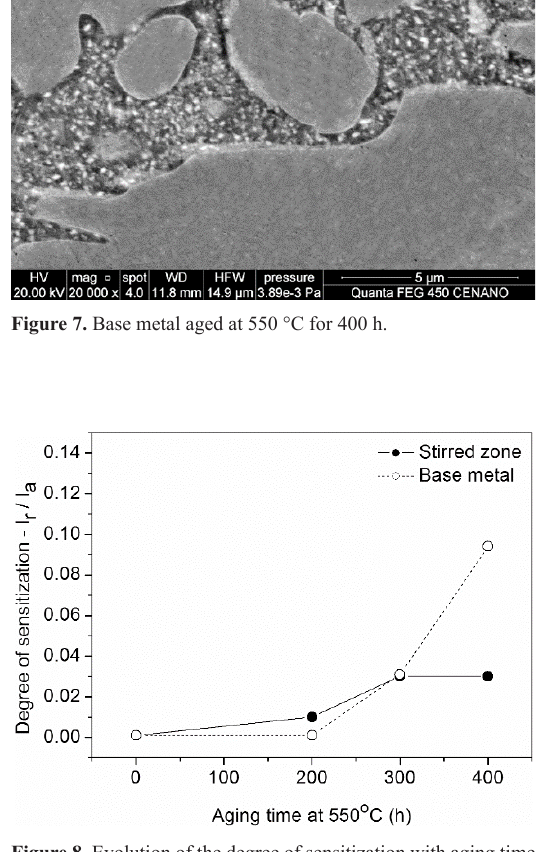
Figure 8. Evolution of the degree of sensitization with aging time at 550 °C for base metal and stirred zone.